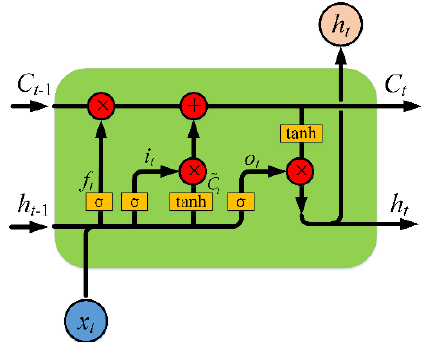
Figure 8. LSTM cell visual representation.